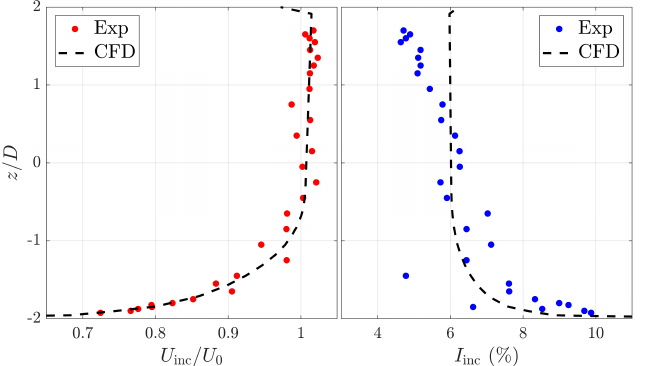
Figure 3. Vertical profile of normalized incoming velocity and turbulence